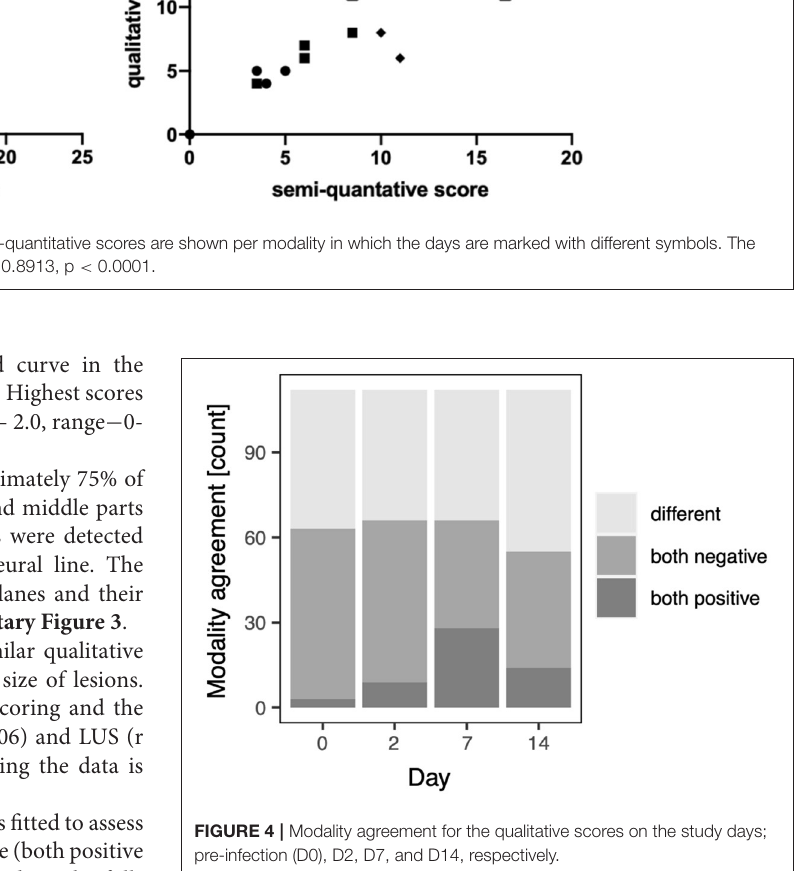
other areas–upper-right, upper-left, and lower-left–are visualized in Supplementary Figure 4